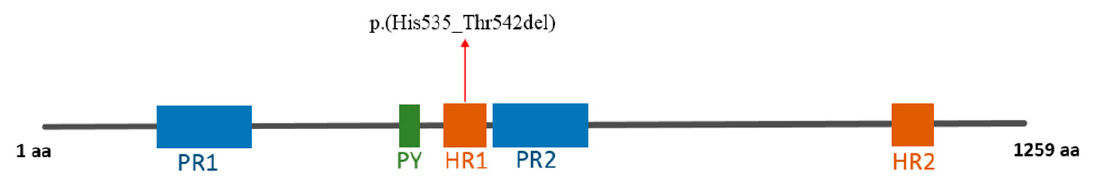
Figure 3. Schematic representation of the structure of AUTS2 protein [17]. The variant identified here is indicated by a red arrow (PR: proline-rich domains; PY: py domain; HR: histidine-rich domains).